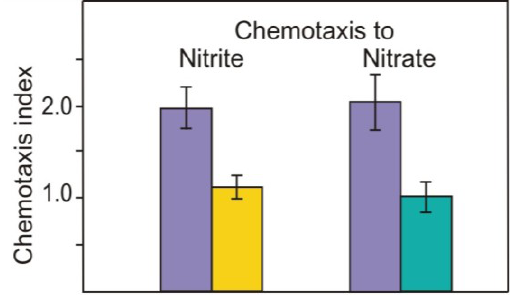
Figure 2. Effect of nitrate and nitrite to the chemotactic responses of CC-124 vegetative cells in different media. Vegetative cells in TAP-N ( ■ ); TAP-N supplied with nitrate (5 mM) ( ■ ), and TAP-N supplemented with nitrite (5 mM) ( ■ ) were assayed for chemotaxis to 5 mM nitrite or 5 mM nitrate as indicated. Data are means ± SD of 3 independent experiments.